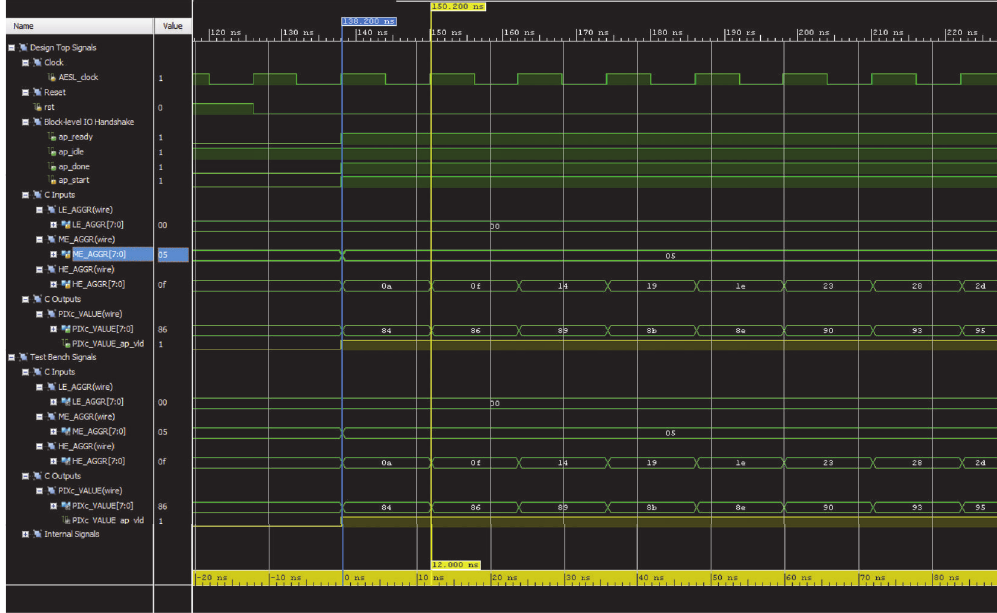
Figure 9: Simulation of the defuzzification unit using the inline function